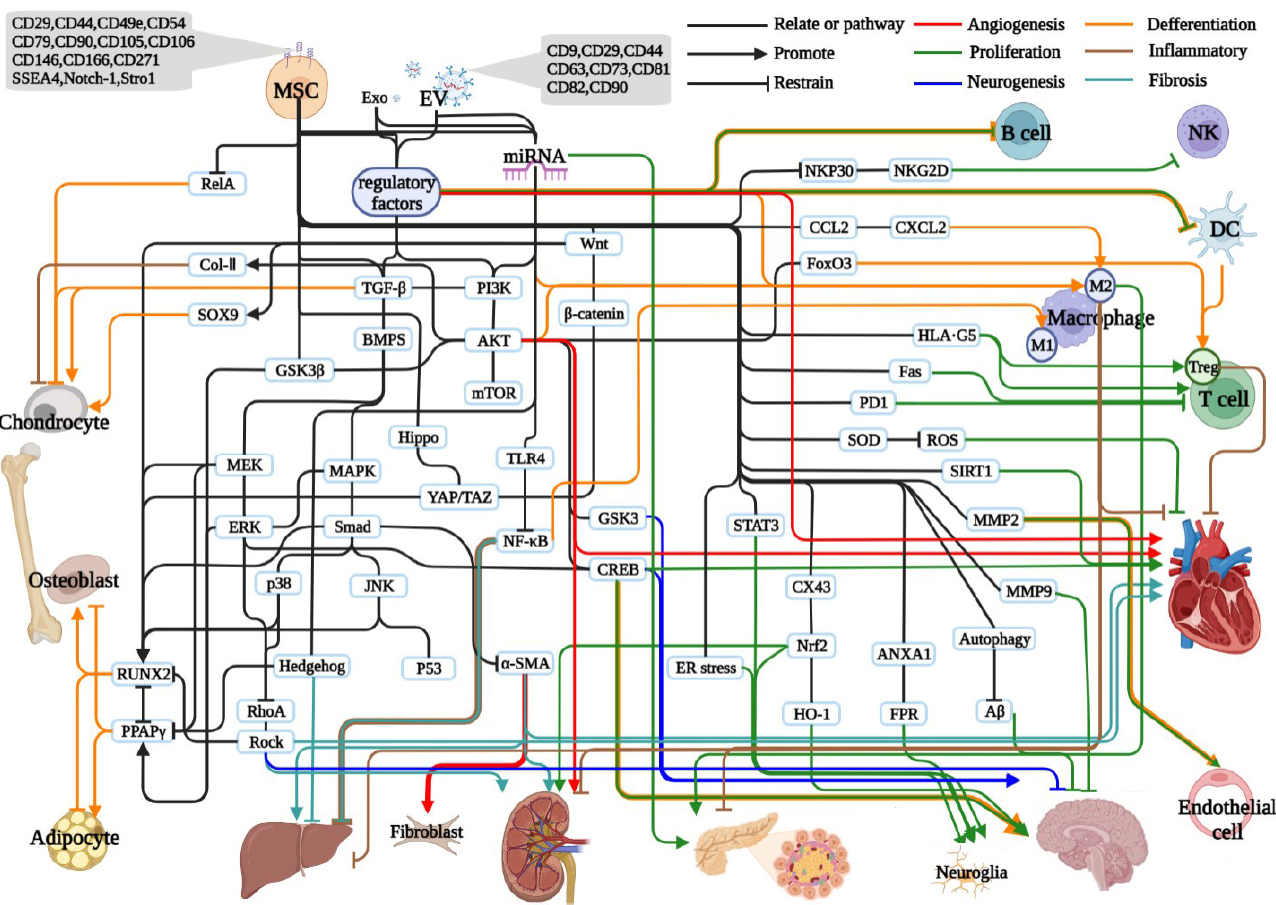
Figure 1. Effects and regulation of MSCs and their exocytotic vesicles in different systems. All solid black lines indicate association or signaling pathways at both ends, solid lines of each color with arrows indicate a promoting relationship, solid lines of each color with horizontal bars represent an inhibiting relationship, solid red lines represent angiogenesis promoting (arrows) or inhibiting (horizontal bars) relationships, solid green lines represent proliferation or apoptosis relationships, blue represents neurogenesis, neuronal proliferation or related inhibition, orange represents promotion or inhibition of differentiation, brown represents promotion or inhibition of inflammatory responses, and cyan represents promotion or inhibition of fibrosis.